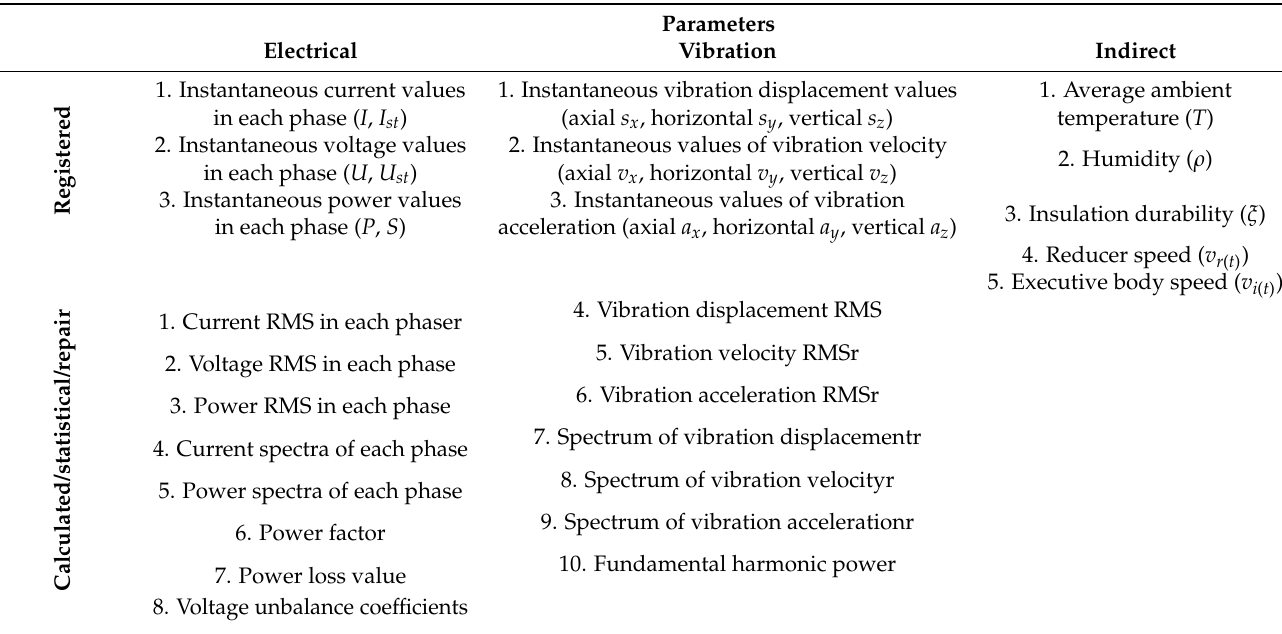
Table 1. Monitored parameters of asynchronous motors.